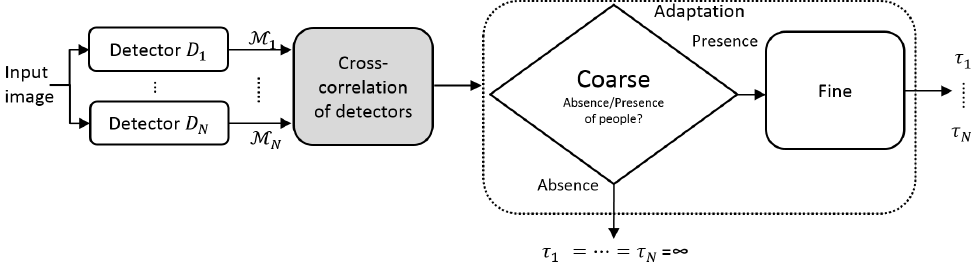
Figure 2. Overview of coarse-to-fine adaptation system.